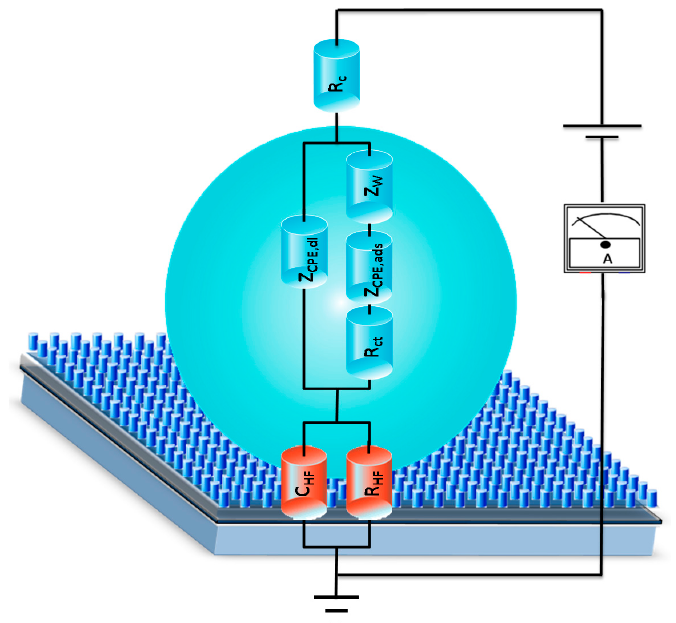
Figure 6. 3D sketch representing the virus in a droplet system on the high hydrophobic T-pSi surface. In the figure the electrical circuit bests fitting the experimental NPs; each circuit element has been superimposed on the corresponding device structure region. Table 1. EIS relevant best-fit parameters for T-pSi exposure to virus droplets at the virus molar concentration under test and V DC = 0.0 V (see text and Figures 2 and 6). Best fit parameters extracted from NP readouts for TRIS-HCl droplet at 0.0 V are reported for comparison.